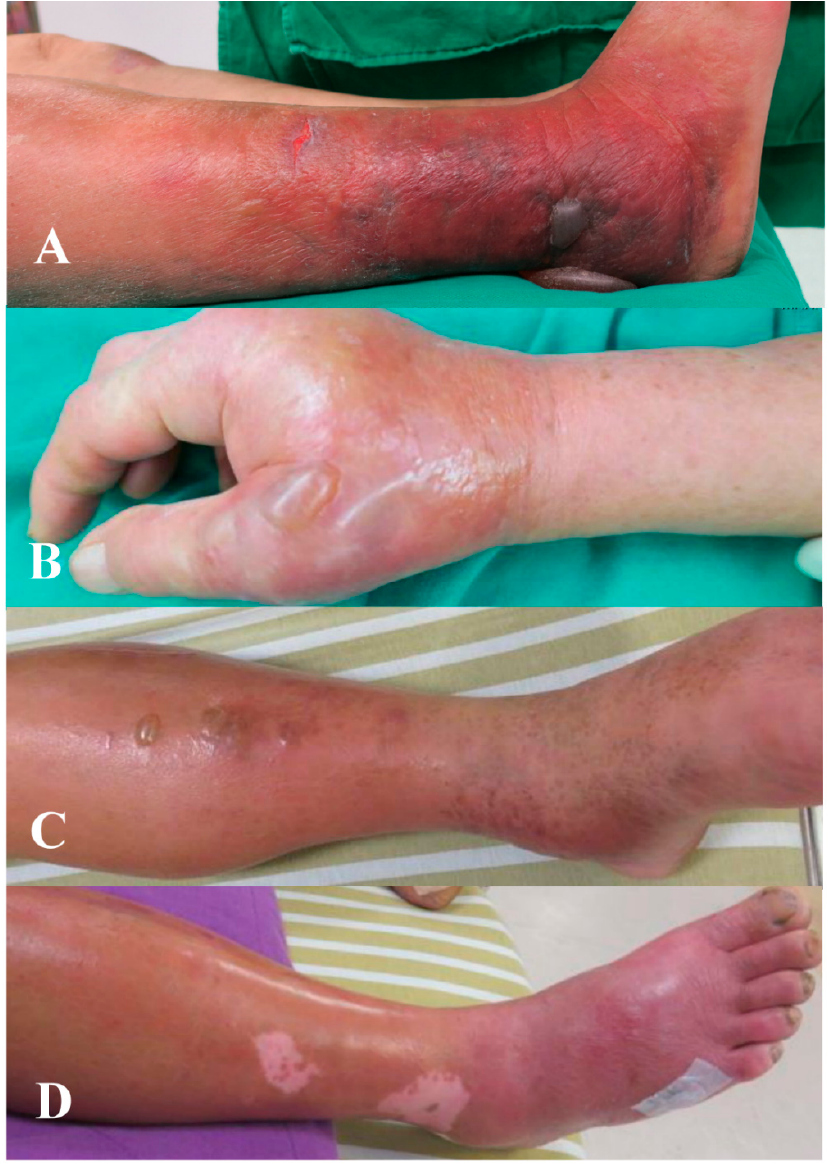
Figure 3. Skin lesions in patients with Gram-positive necrotizing fasciitis. ( A ) A 70 year-old female with MRSA infection revealed to have lower right leg hemorrhagic bullae lesions. ( B ) A 77 year-old female with Streptococcus dysgalactiae in wound culture of left hand revealed to have nonhemorrhagic bullae lesions. ( C ) A 54 year-old male with MSSA infection presented with nonhemorrhagic bullae on lower left leg. ( D ) A 59 year-old male with Corynebacterium infection revealed to have lower right leg nonhemorrhagic bullae lesions.